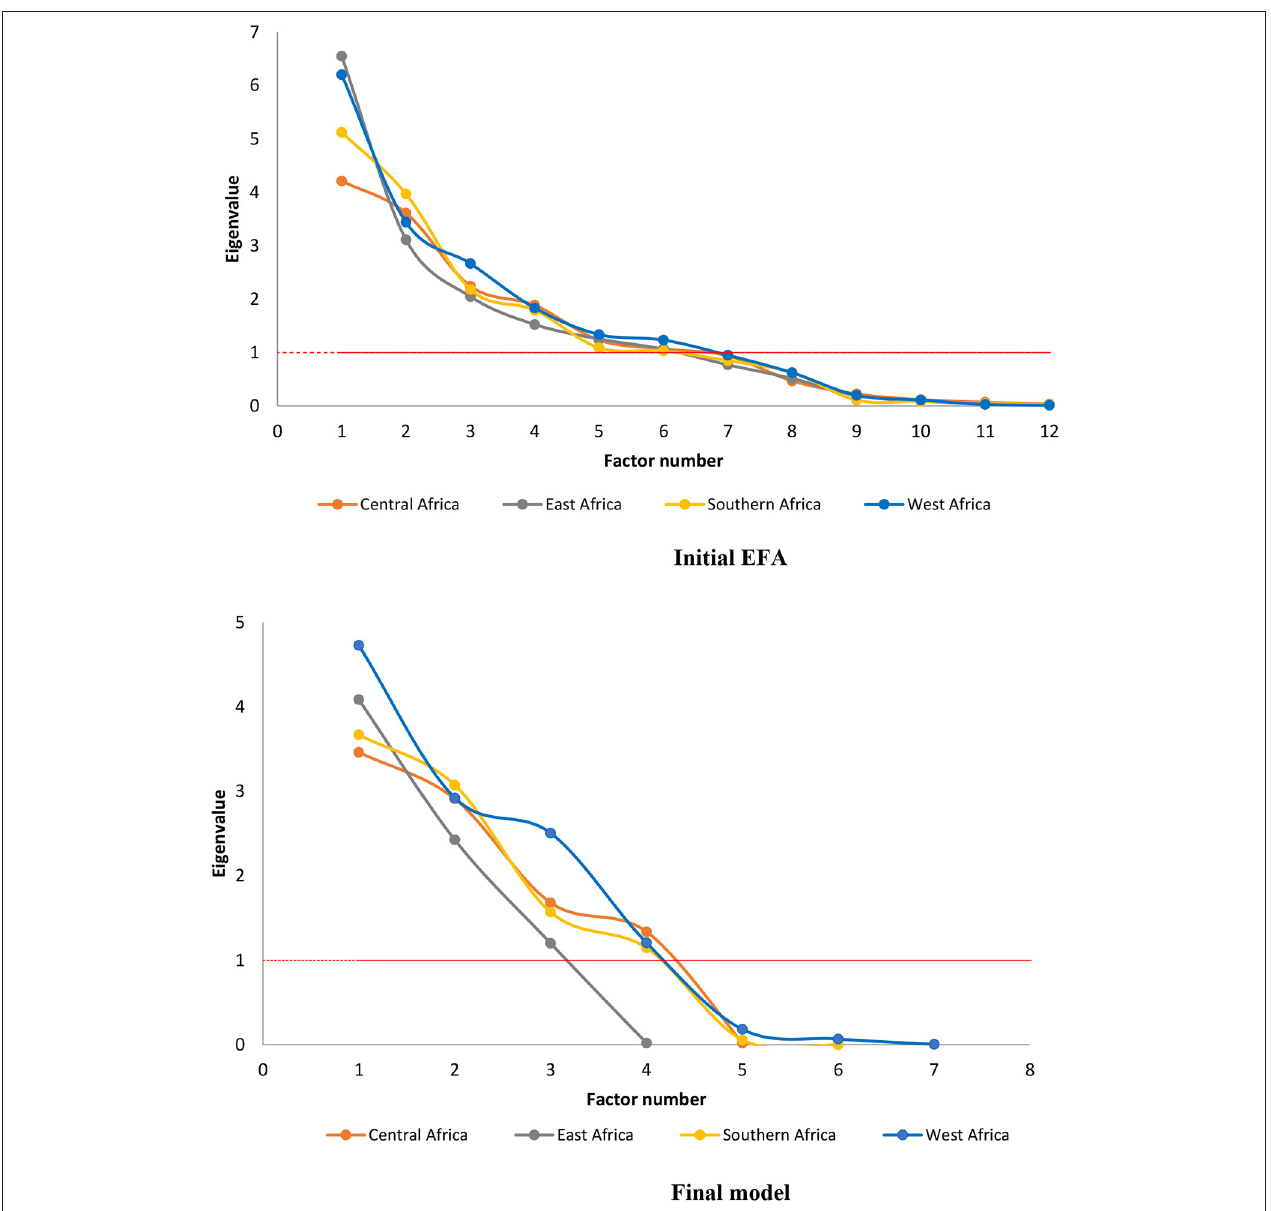
FIGURE 1 | Scree plots of the initial EFA and the final model (after CFA and